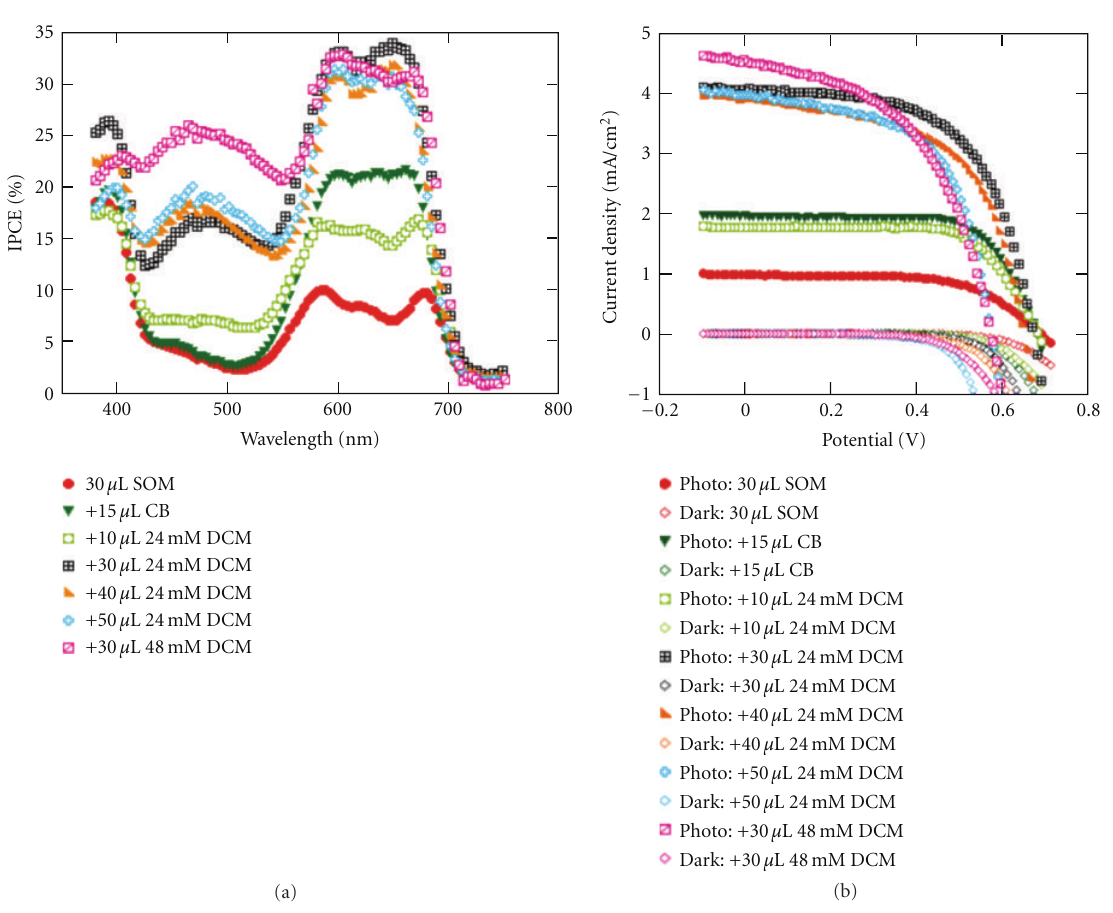
Figure 16: (a) IPCE of FRET-based SS-DSSC devices showing the e ff ect of DCM amount and concentration added to 30 μ L Spiro- OMeTAD-blend solution. All solutions were prepared in chlorobenzene. (b) Photocurrent density-Voltage, of FRET-based photovoltaic devices showing the e ff ect of DCM amount and concentration added to 30 μ L Spiro-OMeTAD-blend solution. All solutions were prepared in chlorobenzene (CB); the e ff ect of diluting the Spiro-OMeTAD-blend with 15 μ L CB is also illustrated. The DCM concentration is 24mM except where noted. Optimal device performance was achieved with 30 μ L of 24mM DCM-pyran in 30 μ L of 0.17 M Spiro-OMeTAD/0.12 M 4-tert butylpyridine/19.5 mM Li[CF 3 SO 2 ] 2 N, with the resulting (typical) device having a fill factor of 0.67, photovoltage of 0.68 V, J sc